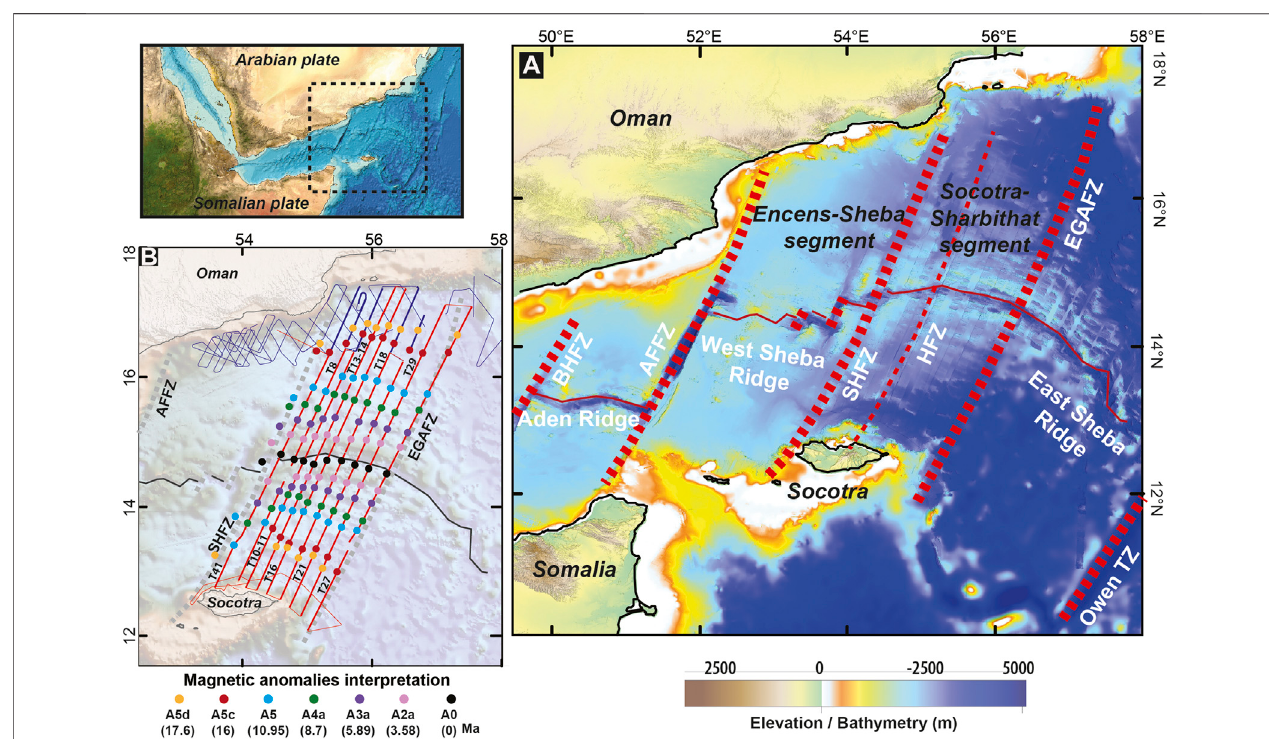
FIGURE 1 | (A) Bathymetric map (GEBCO) showing the studied location with the main fracture zones. BHFZ, Bosaso Hami Fracture Zone; AFFZ, Alula-Fartak Fracture Zone; SHFZ, Socotra-Hadbeen Fracture Zone; HFZ, Hadibo Fracture Zone (this paper); EGAFZ, Eastern Gulf of Aden Fracture Zone; Owen TZ, Owen Transform Zone. In thin red the ridge axis. (B) Location of the ENCENS survey seismic lines (in blue) and Marges-Aden (MAD) survey (in red) associated with the interpreted magnetic anomalies. Thick lines represent the transects used in this study, thin lines represent the other available seismic data.